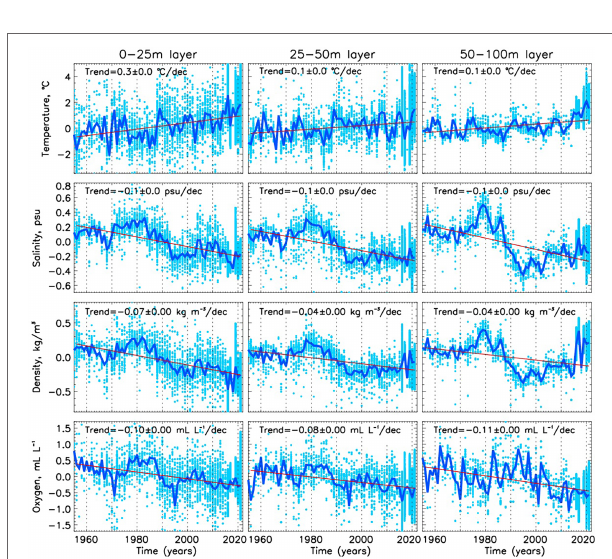
FIGURE 6 | Time series of annual spatially averaged water temperature, salinity, density, and dissolved oxygen anomalies relative to their monthly climatologies based on 1955-2015 and 2018 shipborne observations complemented by 2016, 2017 and 2019-2021 glider observations in the Bothnian Sea. Blue dots are anomalies derived from the individual vertical profiles, blue lines are annual means, red lines show trends computed as linear fit to the blue time